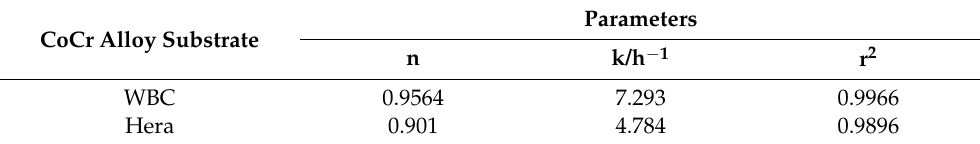
Table 5. Parameters resulting from curve fitting using Equation (2). CoCr Alloy